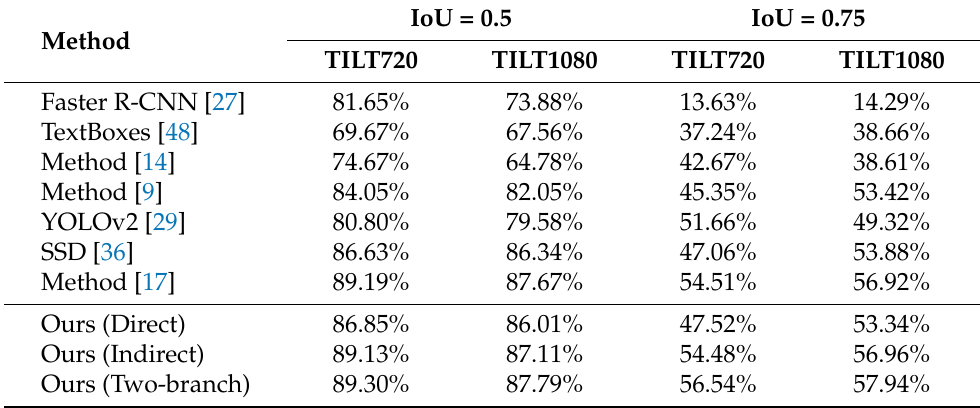
Table 2. Comparative experiments of the horizontal bounding box. The values represent the AP based on the horizontal bounding